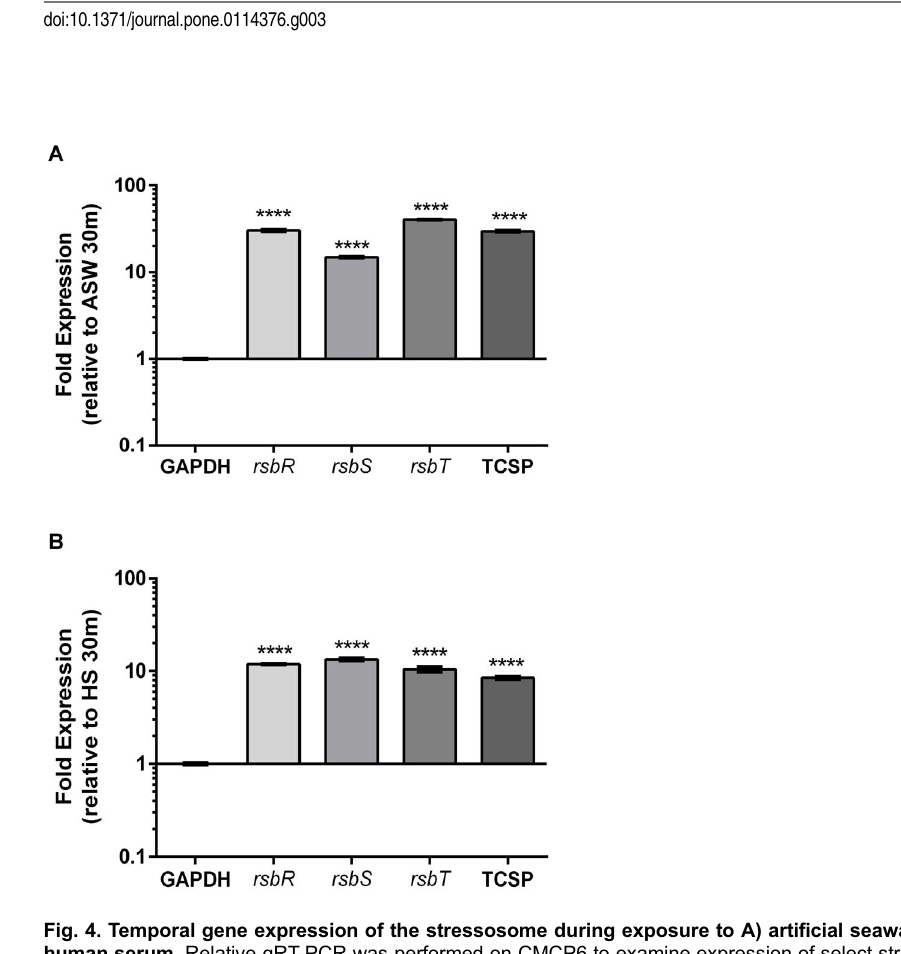
Fig. 3. Gene expression of the stressosome in human serum relative to artificial seawater. Relative qRT-PCR was performed on CMCP6 to examine expression of select stressosome genes ( rsbRST and a downstream two-component sensory protein, here denoted ‘‘TCSP’’) confirming RNAseq results. GAPDH was used to normalize expression data. Asterisks represent significant differences in expression p , 0.0001 (One-way ANOVA).